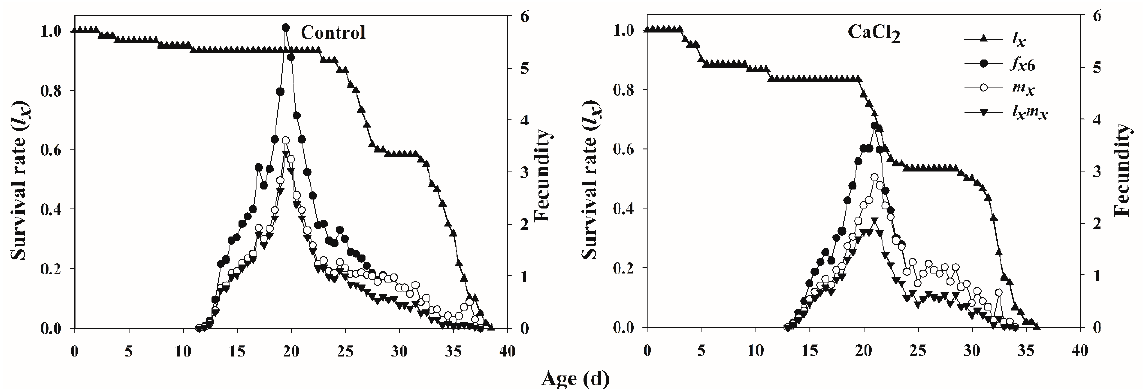
Figure 2. The age-specific survival rate ( l x ), age-stage-specific fecundity ( f xj ), age-specific fecundity ( m x ), and age-specific net maternity ( l x m x ) of Frankliniella occidentalis fed on control and Ca-treated kidney bean leaves.